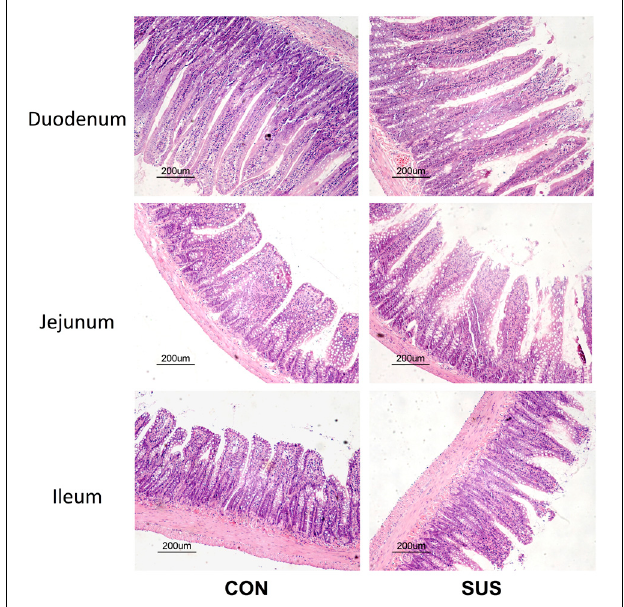
FIGURE 1 | Effects of simulated weightlessness on intestinal morphology in rats. CON, control group; SUS, simulated weightlessness group.